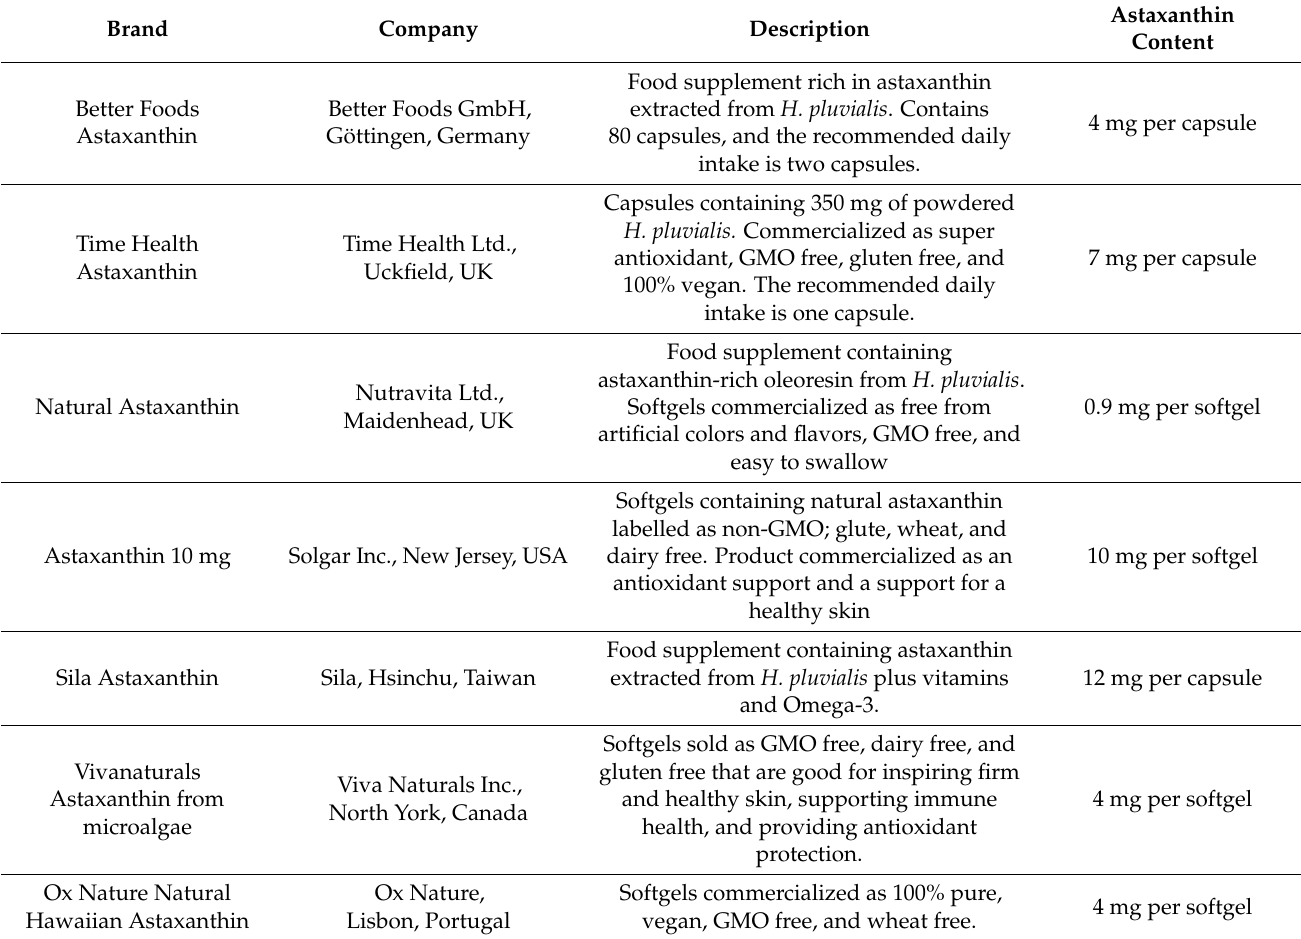
Table 1. Commercial food products containing natural